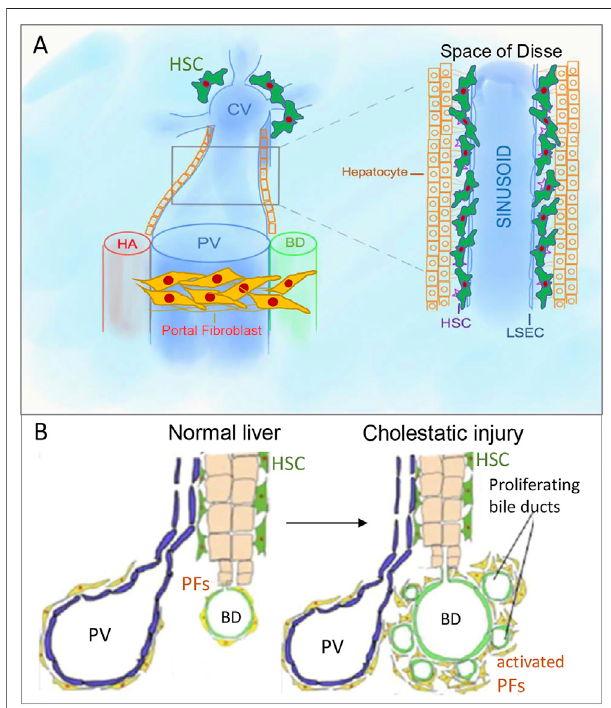
FIGURE 1 | Portal fi broblasts/myo fi broblasts (aPFs/MFs) and hepatic stellate cells (HSCs). (A) . PFs are located around portal triads, while HSCs are located in the space of Disse, which is between sinusoidal endothelial cells and hepatocytes cluster. (B) . Bile ducts proliferate in response to bile duct ligation, known as “ ductular reaction. ” PV, portal vein, CV, central vein, HA, hepatic artery, BD, bile